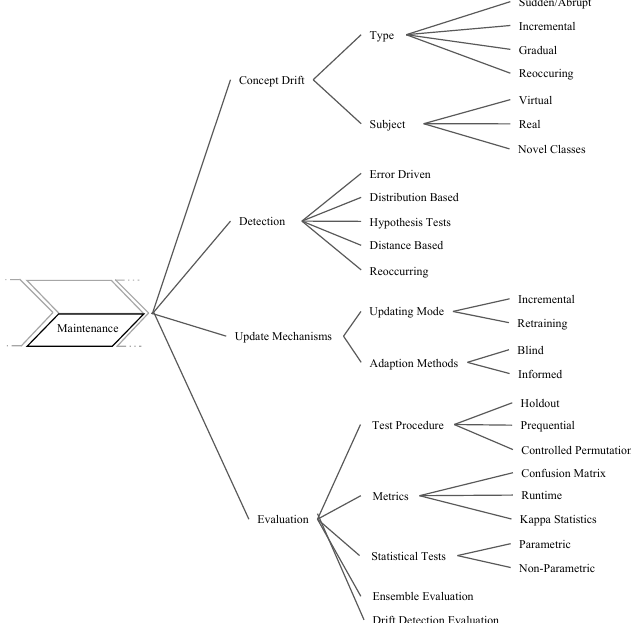
Figure 8. Stream classification model maintenance consits of several building blocks. After an initial setup of the algorithm, the model is maintained, while predictions are made simultaneously.